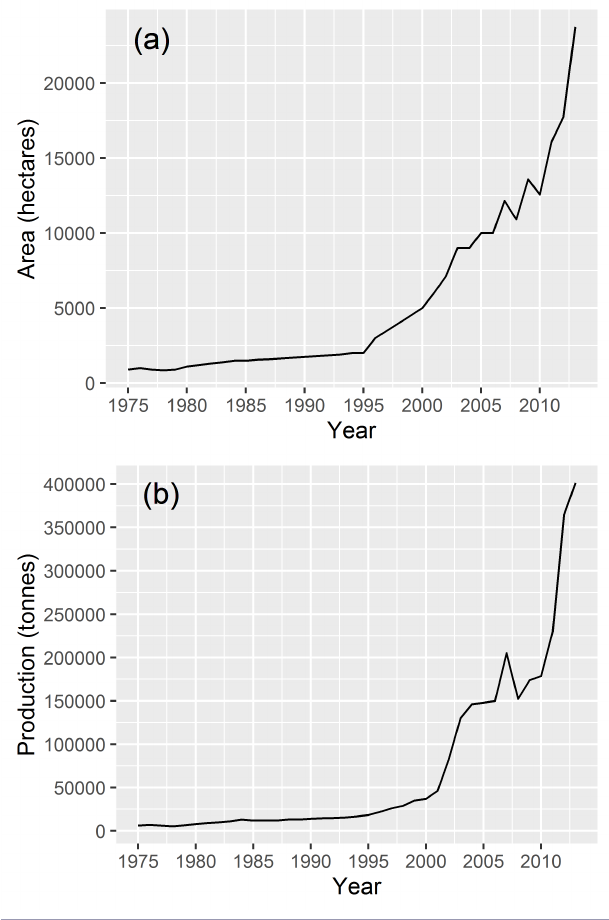
Fig. 2. Area of banana harvested (A) and production of banana (B) in Lao PDR between 1975 and 2013. Data: FAO